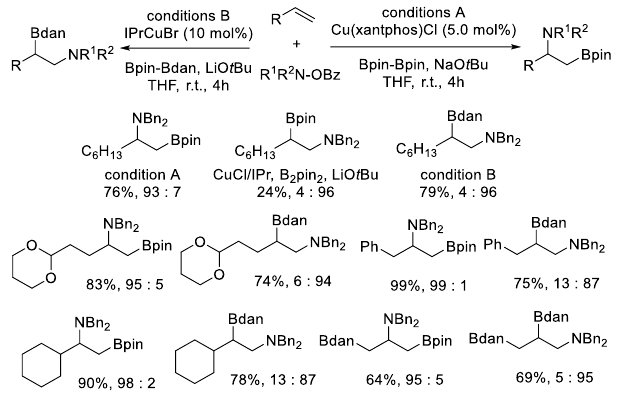
Scheme 18. Regiodivergent Cu-catalyzed aminoboration of terminal